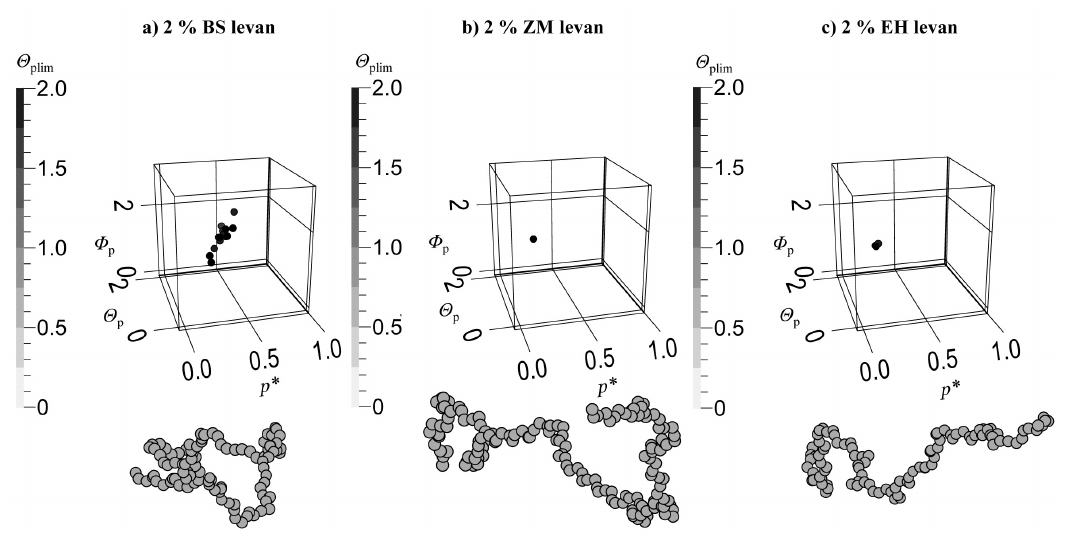
Figure 3. Graphical presentation of the results of the string-of-beads model obtained for the experimental scattering curves shown in Figure 2b. Be- low: Best-fit conformations for: a) 2 wt % BS levan ( Θ Φ = 1.296, and p * = 0.25) and c) 2 wt % EH levan ( Θ p sented as grayscale points in 3D